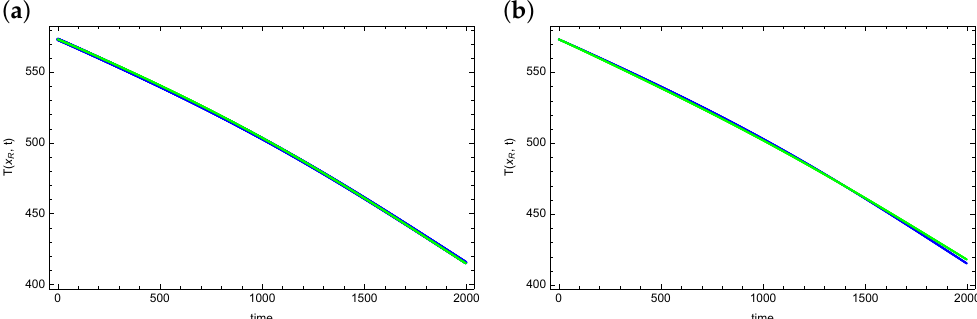
Figure 5. The exact temperature T ( x R , t ) in measurement point (blue line) and reconstructed temper- ature (green line) for ( a ) AO and ( b )